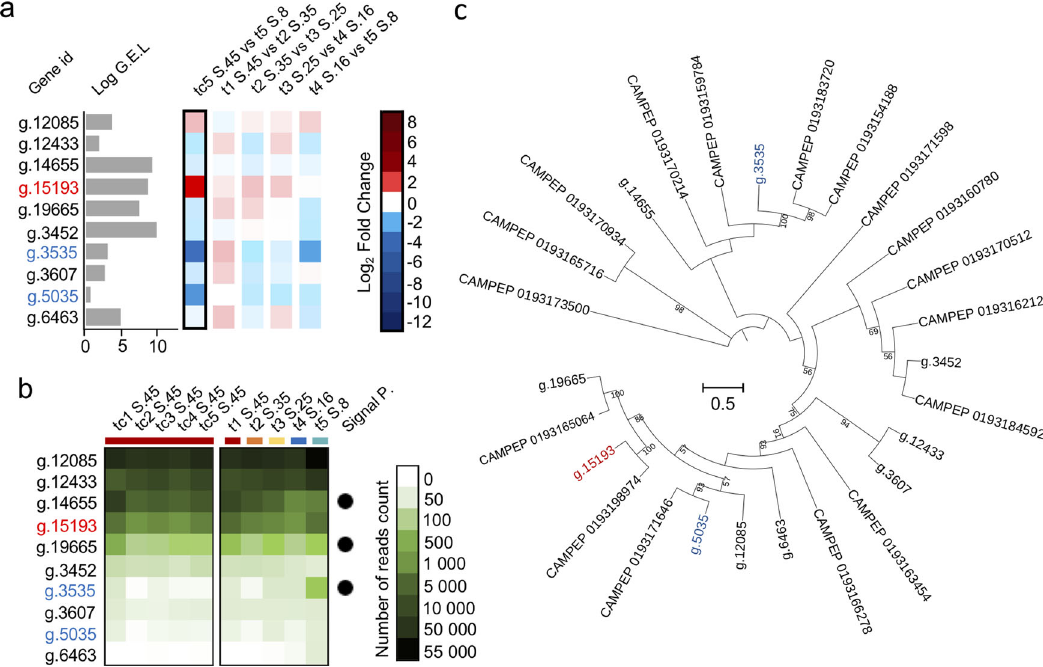
Fig. 7 Ice-binding proteins from DUF3494 in this study. a Barplot and heatmap of the ten genes coding for the DUF3494 (PF11999). Barplot indicates the log gene expression level (G.E.L.) for each gene. The log 2 fold change for each comparison of salinity (see Figs. 3 and 4) are indicated by the blue and red colors. b Heatmaps show the average (triplicate) of the number of reads per gene for each condition of salinity. On the right, are the control (salinity 45) following the time of sampling. On the left are the results of the progressive change of salinity (S.). The presence of a signal peptide (P.) is indicated with a black circle. c Maximum Likelihood tree generated using RAxML PROTGAMMAGTR from an alignment of 27 short sequences from the ten genes coding for ice-binding proteins found in all transcriptomes of this study and 17 short sequences from MMETSP transcriptomes of the same alga (CCMP2097). The tree was constructed with an alignment of 613 amino acids with bootstrap support repeated 1000 times. Only bootstrap support >50 (of 100) is